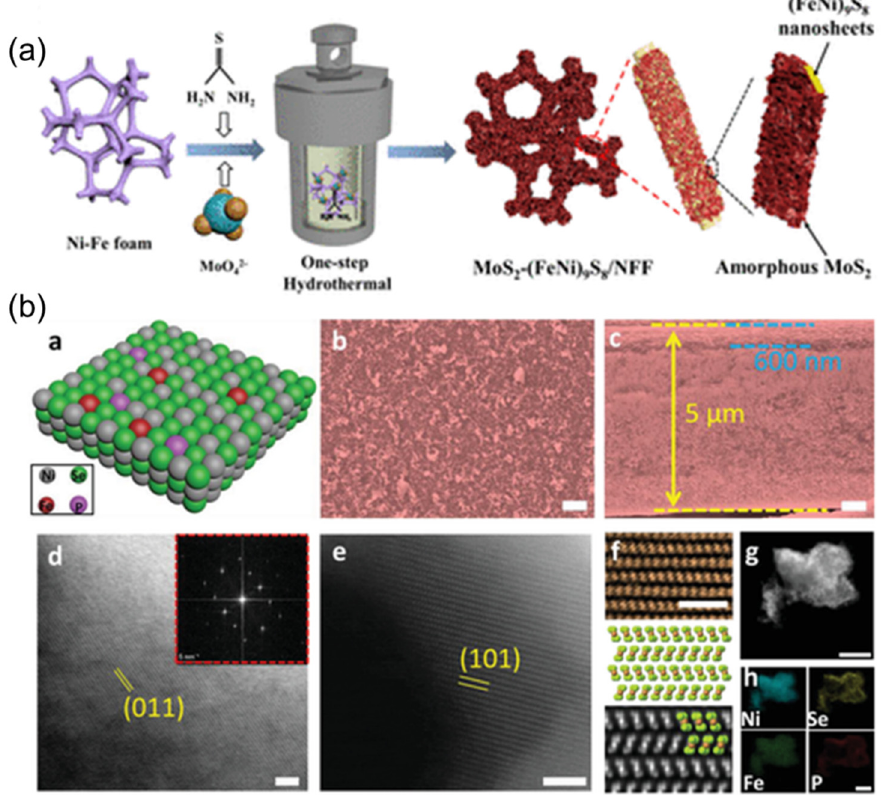
Figure 9. ( a ) Schematic diagram for the MoS 2 -(FeNi) 9 S 8 /NFF preparation [50]; ( b ) chematic diagram for the Fe,P-NiSe 2 NFs preparation [51].